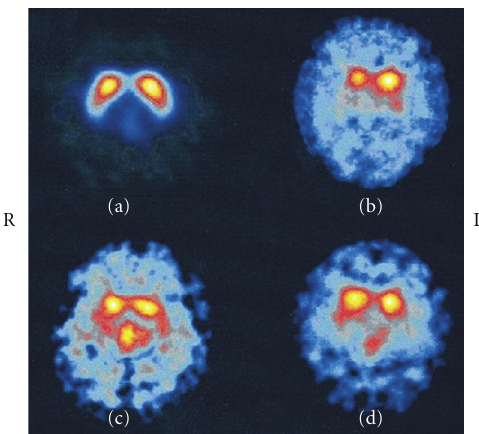
Figure 2: Transverse 123 I- β -CIT images. (a) The image from a healthy control. (b) in PD patient the uptake is markedly reduced, with putamen more a ff ected than caudate, and the right striatum (opposite to the side of more severe symptoms) showing the largest dopamine transporter (DAT) loss. (c) In MSA-striatonigral degen- eration (MSA-SND) patient, the uptake is significantly reduced in both caudate and putamen and indicates more symmetric loss of DAT. (d) In the MSA-Shy-Drager syndrome (SDS) patient, the uptake is also significantly reduced, with putamen more a ff ected than caudate; the loss of DAT appears to be symmetric